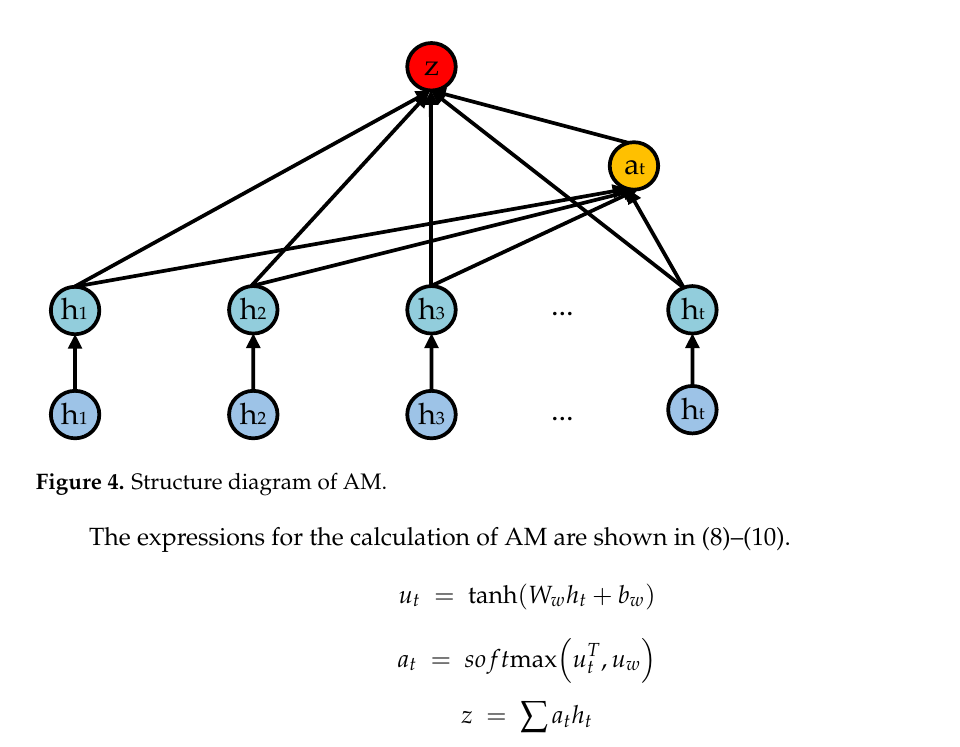
Table 1. NASA dataset lithium-ion battery